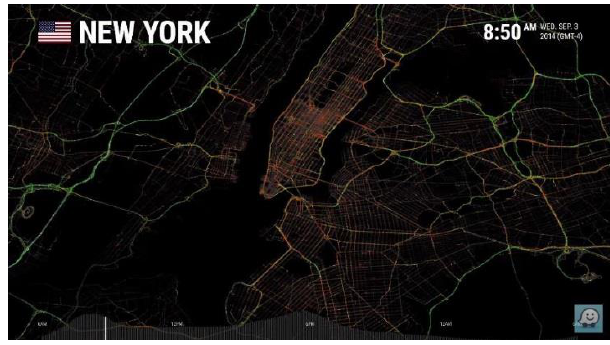
Figure 2. Data Visualization – New York: A day in Waze